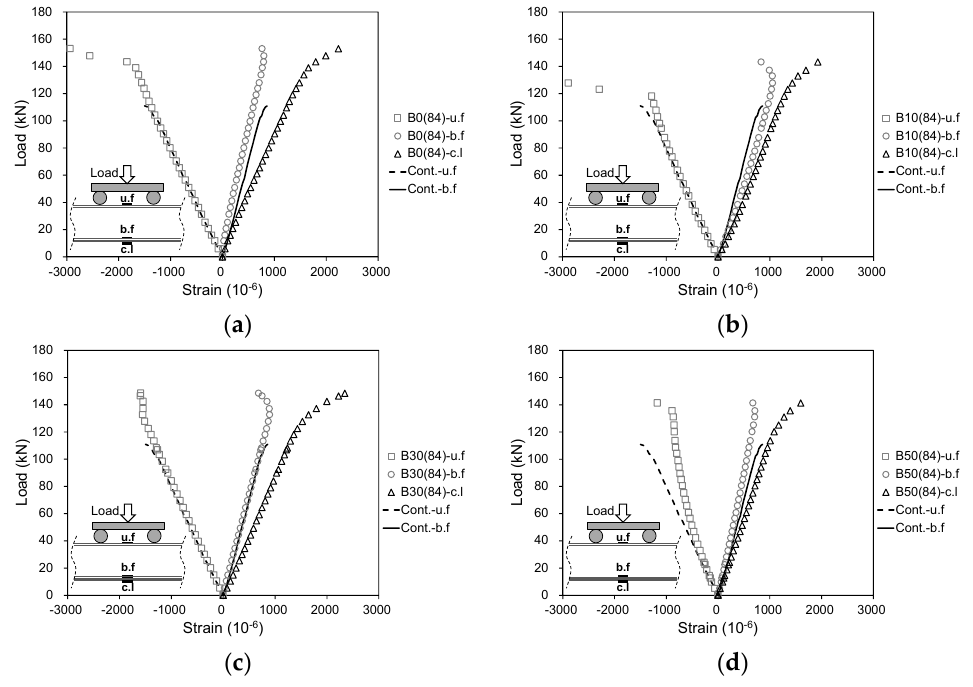
Figure 9. Load-strain responses of beams tested at 84 days: ( a ) Beam B0; ( b ) Beam B10; ( c ) Beam B30; ( d ) Beam B50.